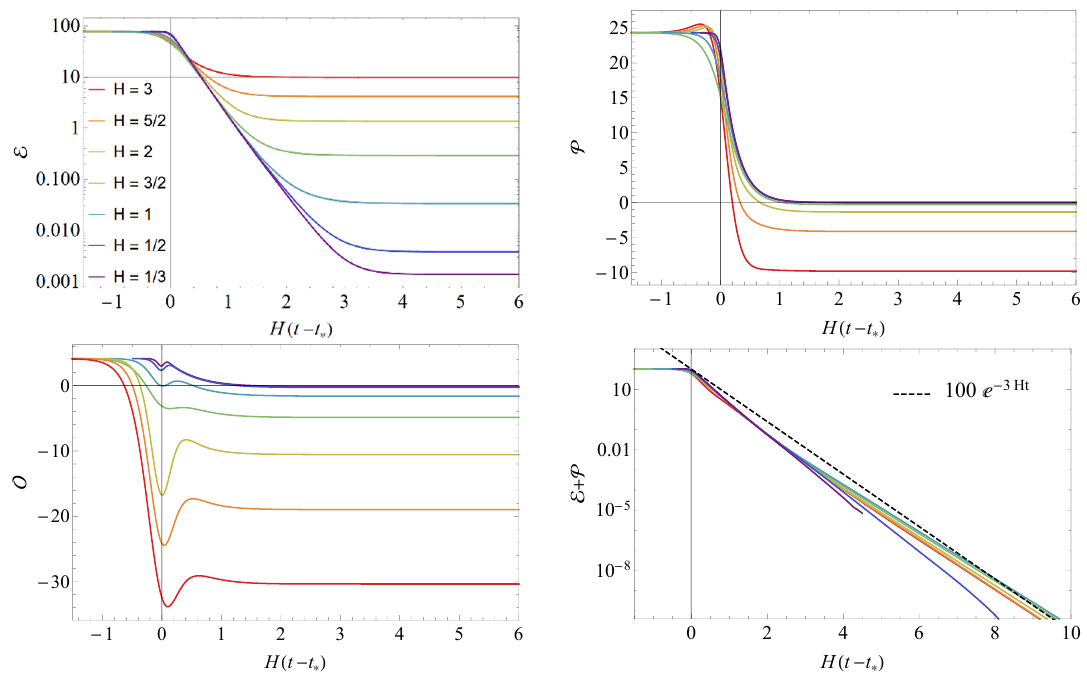
Figure 4 . (Top) Energy density (left) and pressure (right) as functions of time for different values of H . (Bottom) Expectation value of the scalar operator (left) and the combination E + P as functions of time for different values of H . The black dashed line is the expansion factor e − 3 Ht of a fluid with zero pressure. All dimensionful quantities are measured in units of M and we set α = 0 , β = 1 / 16